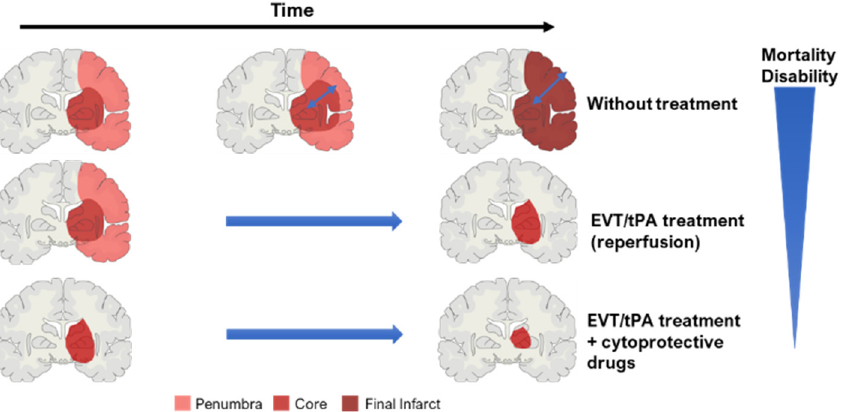
Figure 1. Concept of ischemic core and penumbra, and their progression through time (EVT—endovascular/mechanical thrombectomy; tPA—thrombolysis). The blue arrow within the brain in the ‘without treatment’ condition represents core expansion.